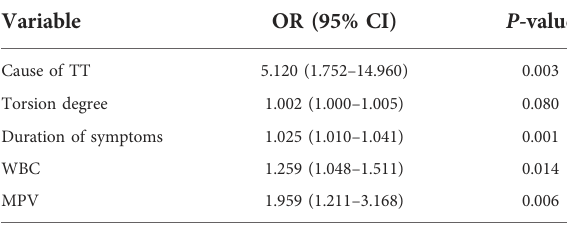
TABLE 5 Results of multivariable analysis between patients underwent orchidopexy and orchiectomy by logistic regression analysis.